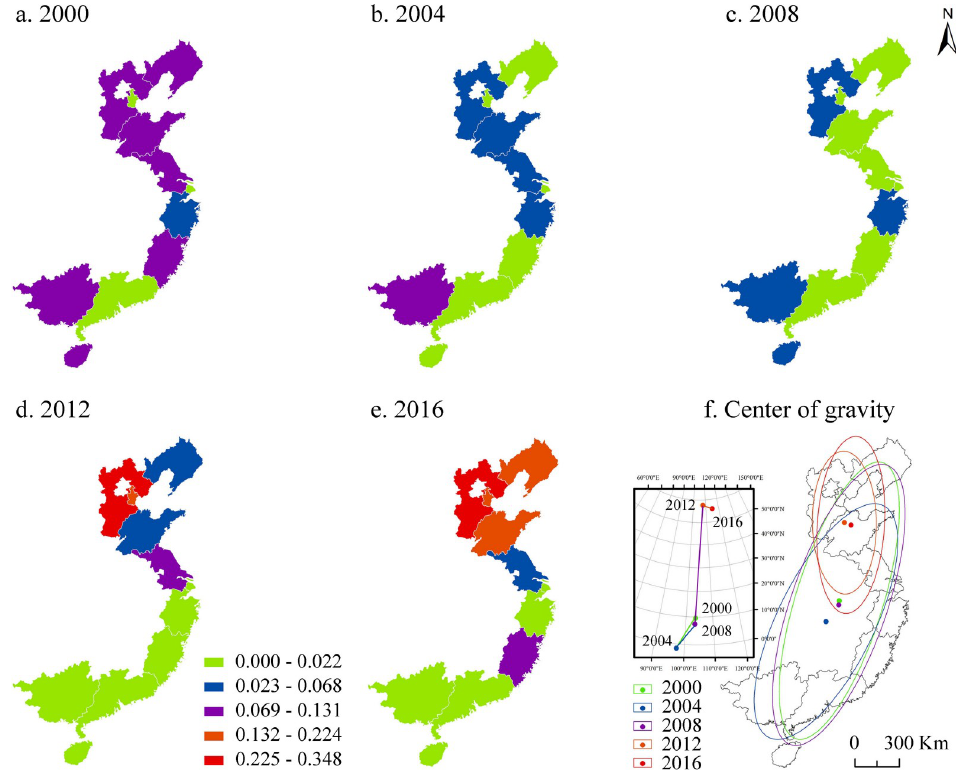
Fig 3. The evolution of the spatial pattern of marine resource